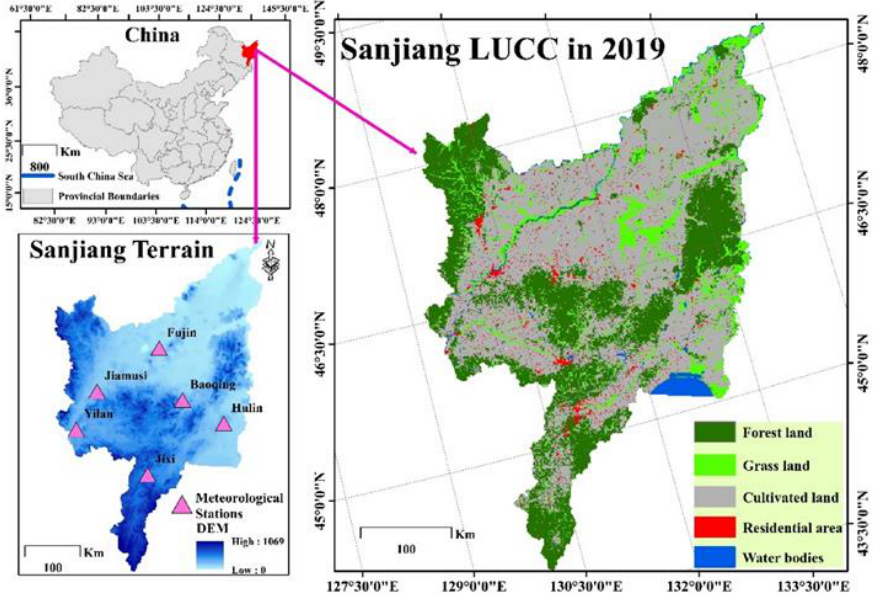
Figure 1. The Sanjiang Plain is located in the mid-high latitude area in China.